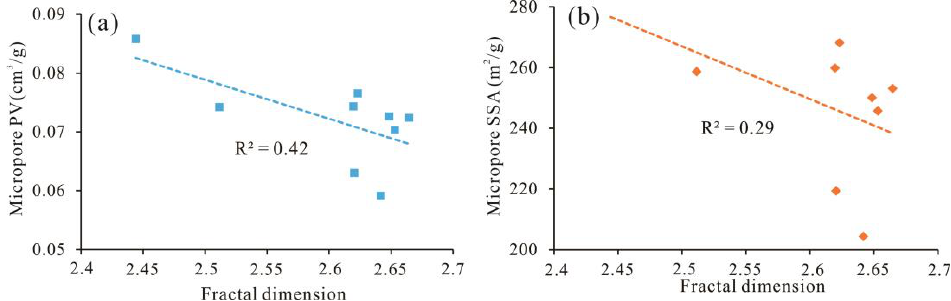
Figure 14. Relationships between the micropore fractal dimension and ( a ) micro-PV and ( b ) micro-